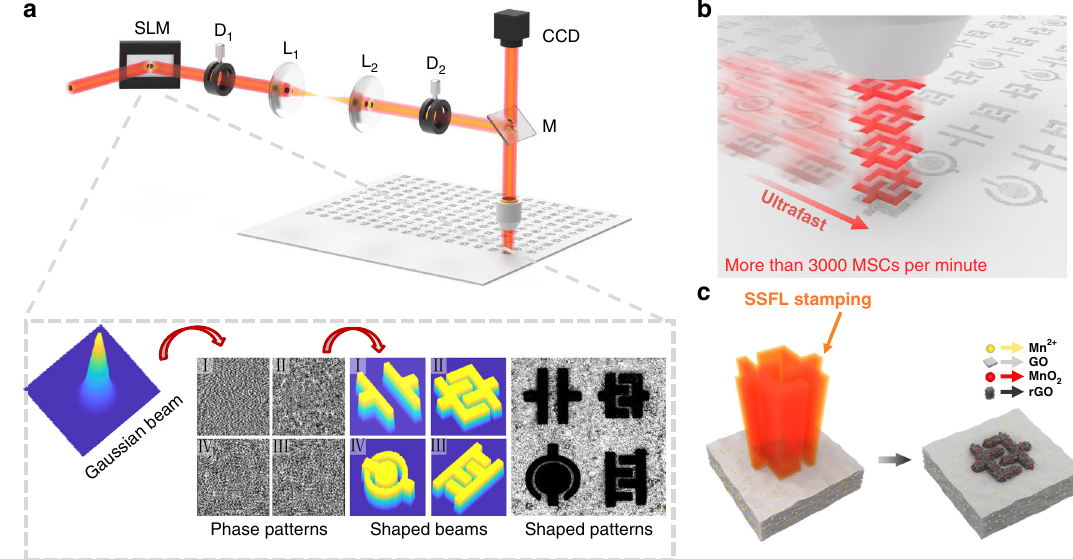
Fig. 1 Schematics of SSFL strategy to fabricate the graphene/MnO 2 MSCs. a Gaussian beams were transformed into arbitrary geometric target beams in SLM by programming phase patterns, adjusted collimation by two diaphragms (D1, D2) and transmitted by the 4f relay system including two convex lenses (L1, L2) and the dielectric mirror (M). b The ultrafast processing via SSFL on hybrid GO fi lms. c Schematic illustration showing the fabrication process for graphene/MnO 2 MSCs using SSFL